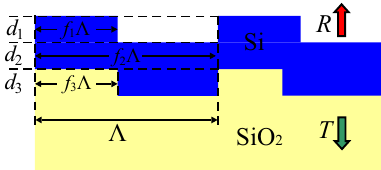
Figure 2: Geometry of the periodic-grating optical fil- ter, depicting the geometric parameters that are considered